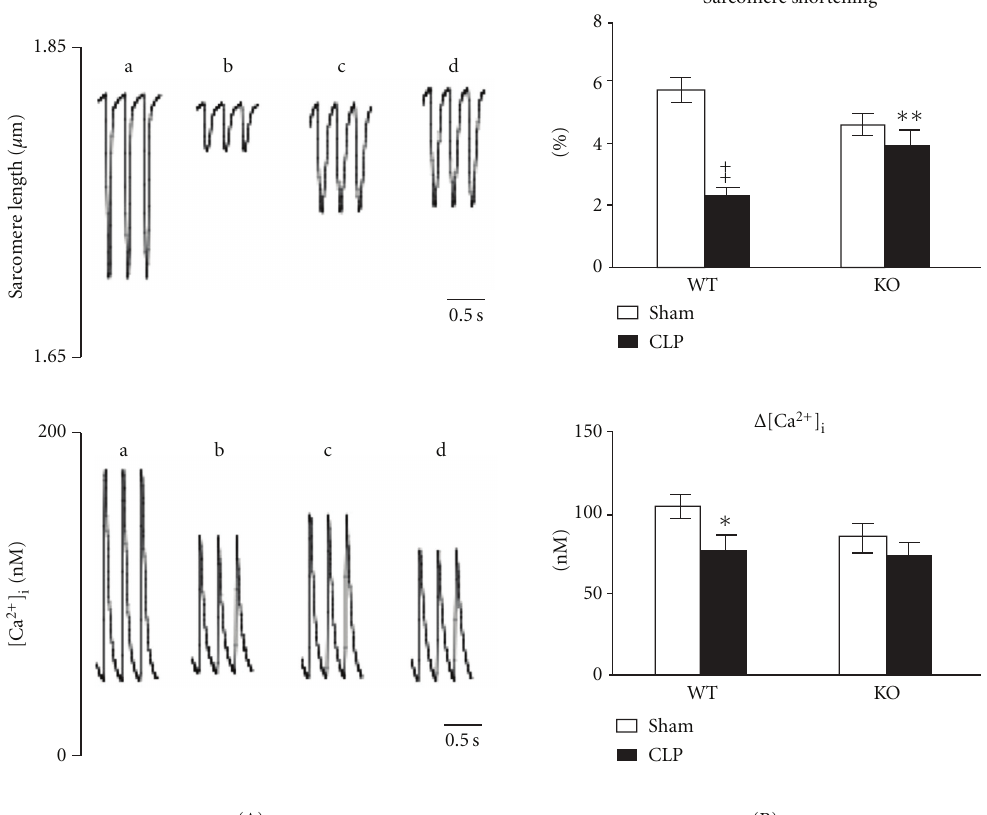
(B) Figure 6: TLR2 − / − mice have improved cardiomyocyte function after polymicrobial sepsis. Wild-type (WT) and TLR2 − / − mice underwent sham or cecum ligation and puncture (CLP) procedures. Twenty-four hours later, the hearts were harvested and cardiomyocytes were iso- lated. A , Representative tracing of sarcomere shortening and Ca 2+ transients in cardiomyocytes isolated from WT (a, b) and TLR2 − / − (c, d) mice subjected to either sham (a, c) or CLP (b, d) surgeries. B , Accumulated data of sarcomere shortening and Ca 2+ transients. Each error bar represents mean ± SE. The data in each group were recorded from 16 to 27 single adult cardiomyocytes isolated from more than four mice. ∗ P < 0 . 05 versus WT sham; ∗∗ P < 0 . 01 versus WT CLP; ‡ P < 0 . 001 versus WT sham. KO, knockout (TLR2 − / − ). (Zou et al., [124], used with